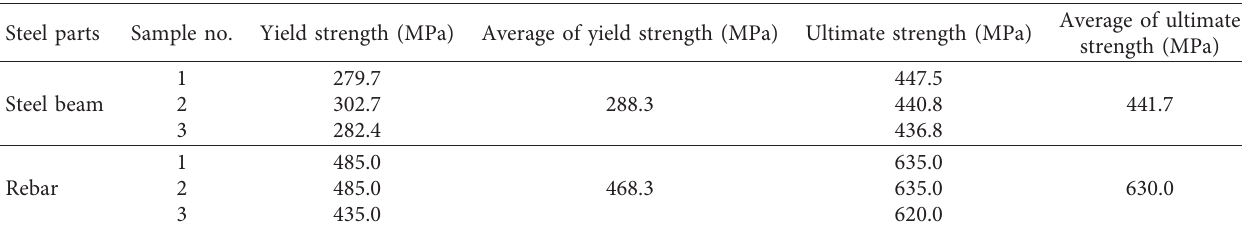
Table 3: Material properties of the unfired